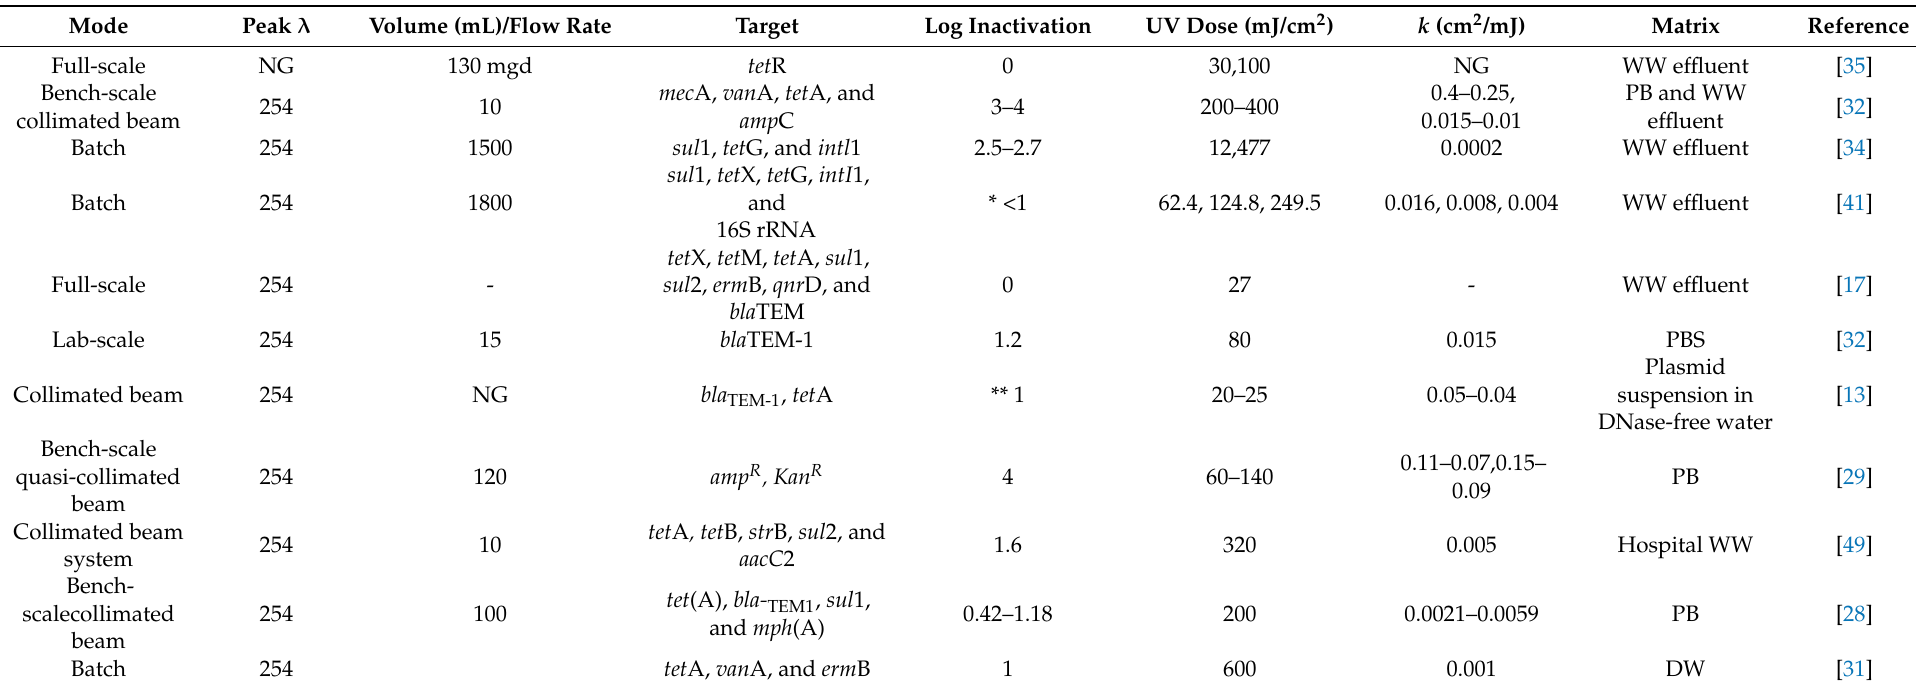
Table 1. Inactivation of ARGs by UV